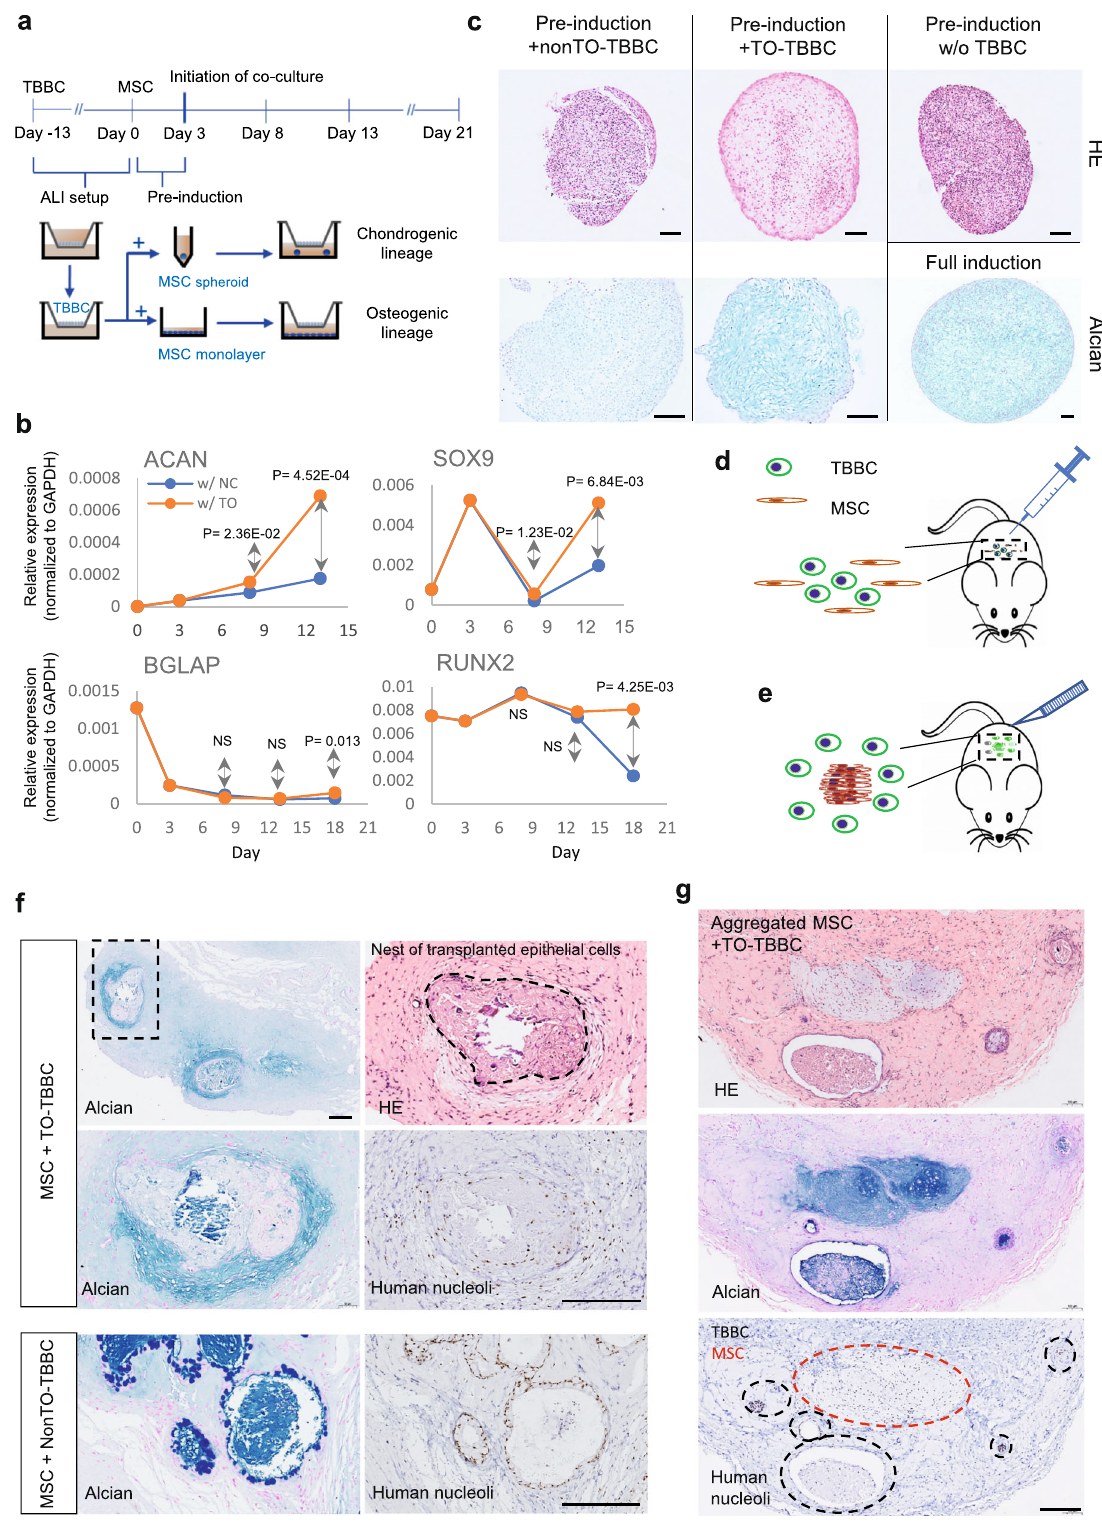
chondrogenesis 38 , its elevation in TO nodules enhances current fi ndings and further demonstrates an active role of TO-TBBC in chondrogenesis by stimulating mesenchymal cells and modulating the local